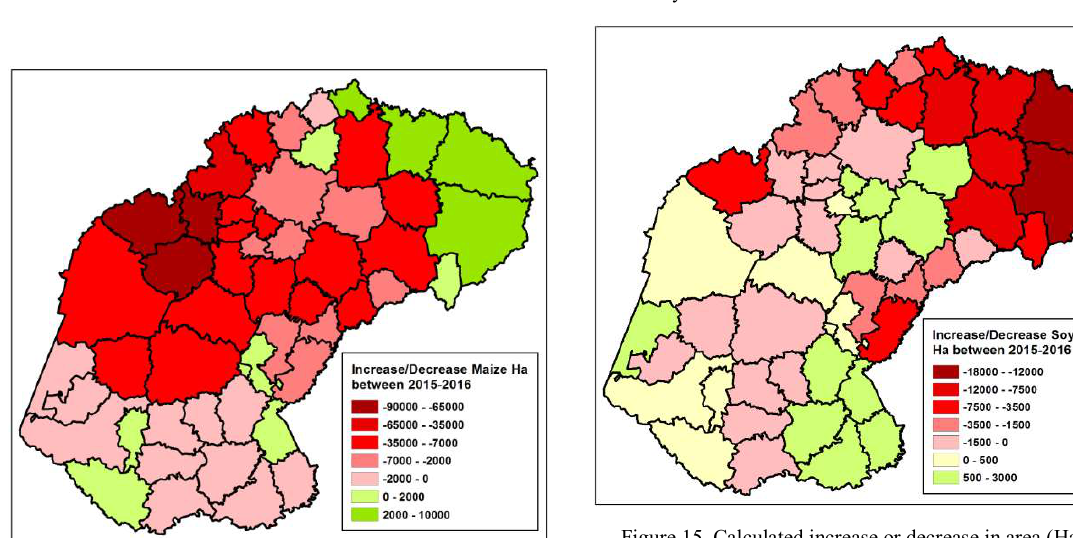
Figure 14. Calculated increase or decrease in area (Ha) of soybeans cultivated in 2014 and 2015 in Freestate